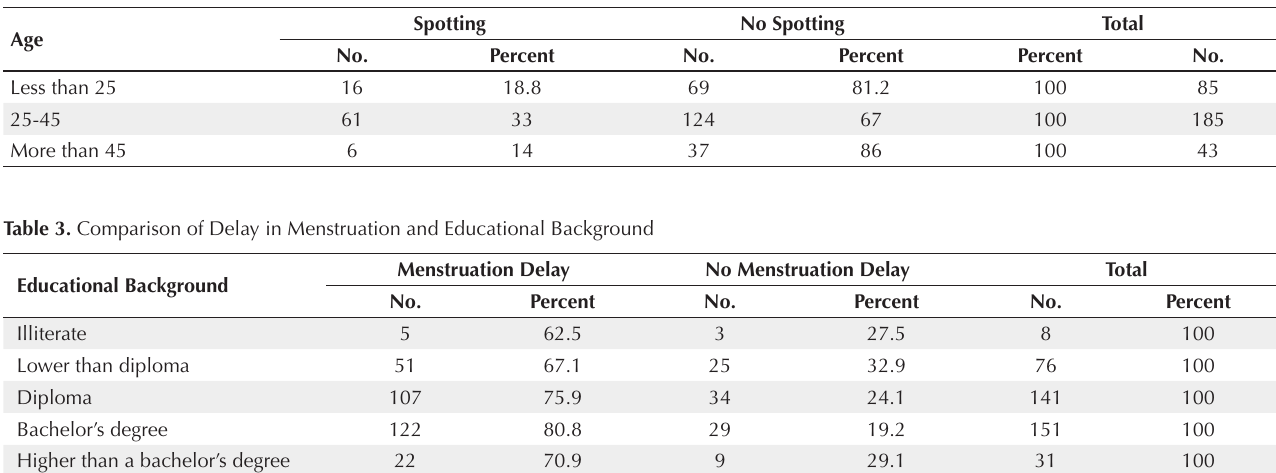
Table 2. Spotting Frequency by Age Group Age